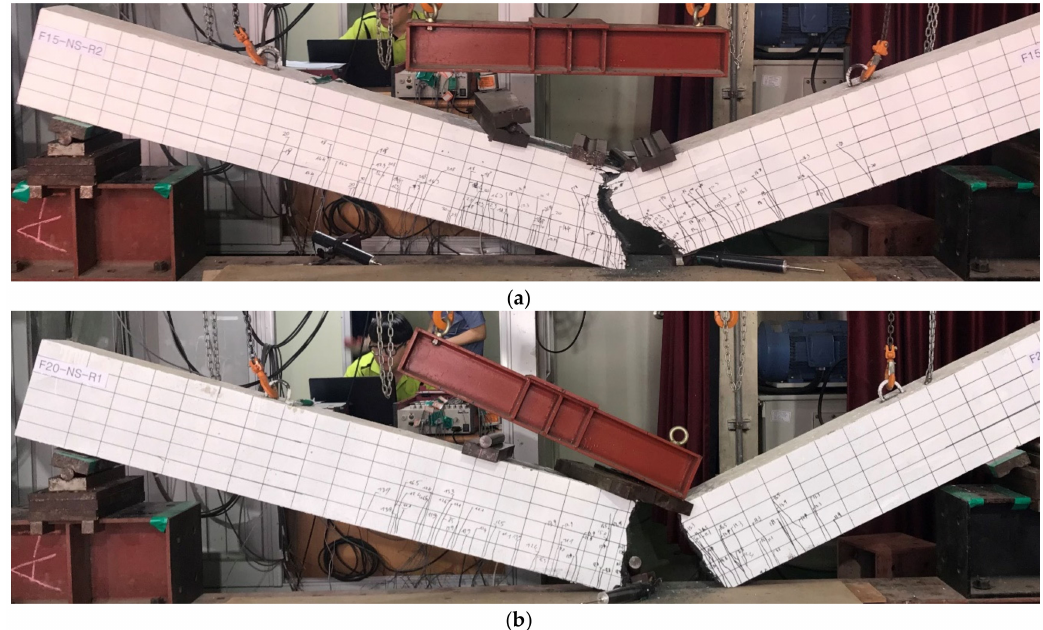
Figure 12. Failure of the UHPC beams by rebar fracture. ( a ) Failure of the UHPC-F15-R2 beam; ( b ) failure of the UHPC-F20-R1